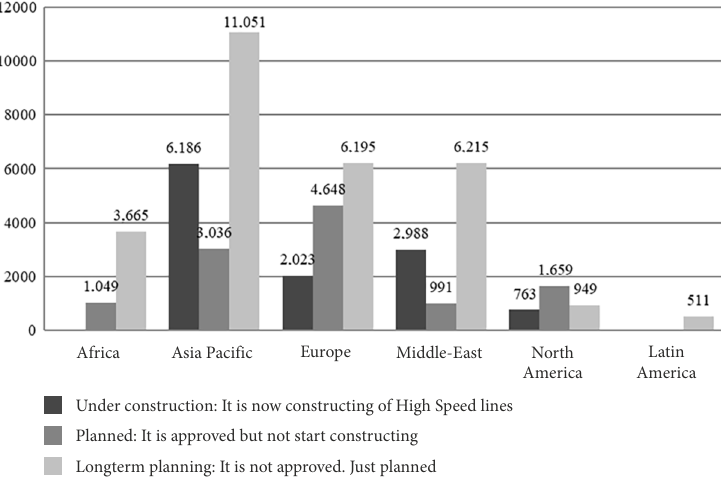
Figure 1. HSR Mileages in major areas (unit: